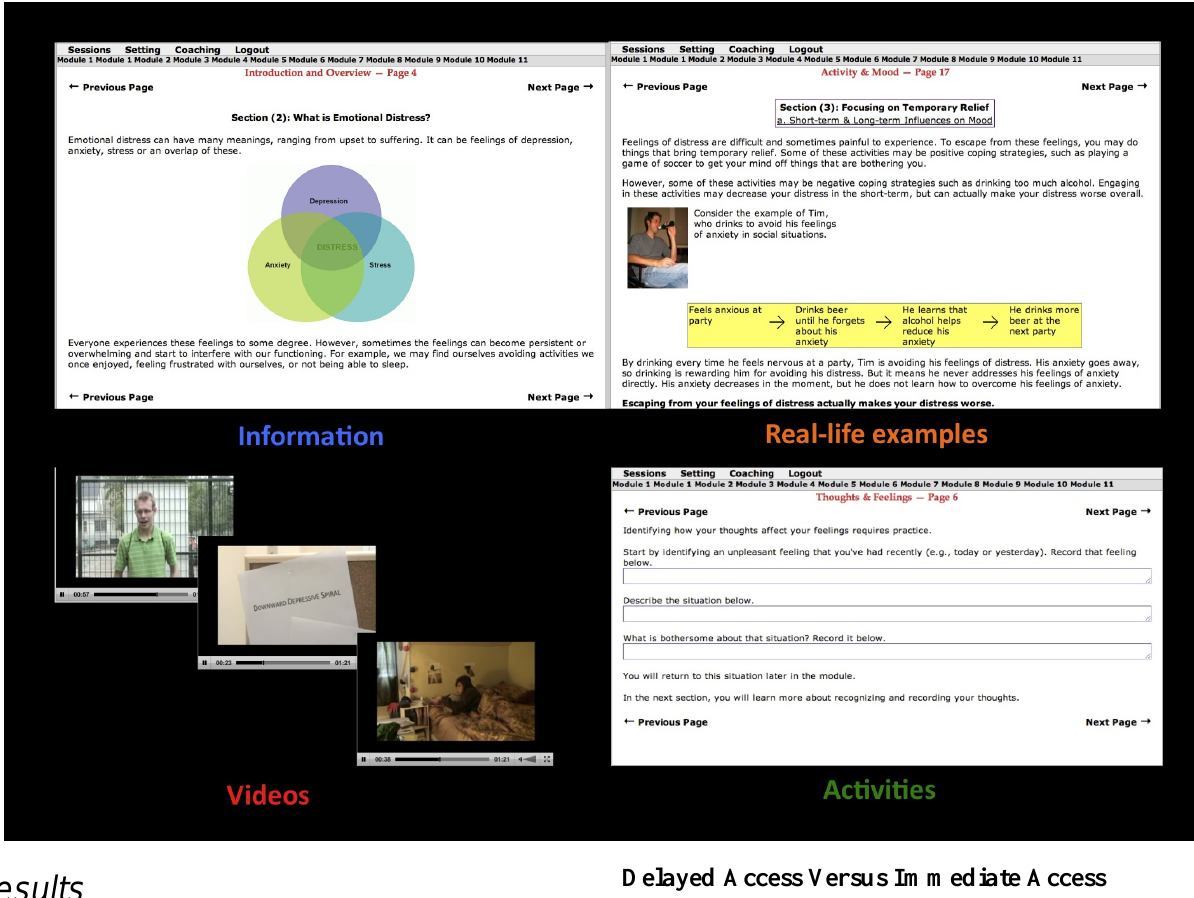
Figure 2. Screenshots of the online-based